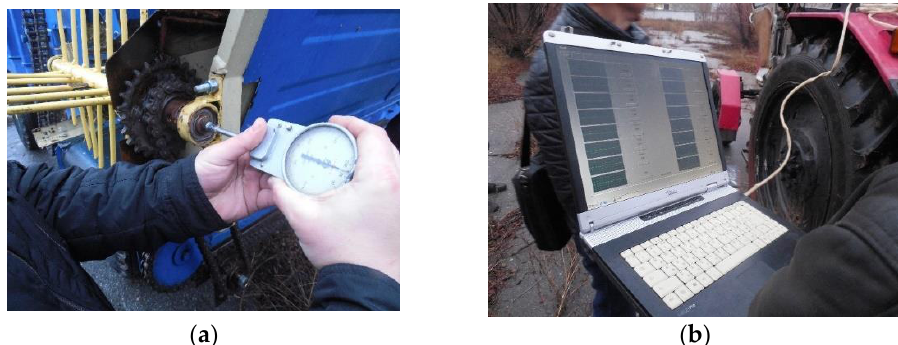
Figure 4. Determination of the rotation speed of the spreader working body shaft and the PTO shaft ( a ) and registering devices: PC and Oscill software ( b ) (for clarity and complete display of the drive and the working body, the protective barriers were dismantled at the time of photo-fixa- tion).